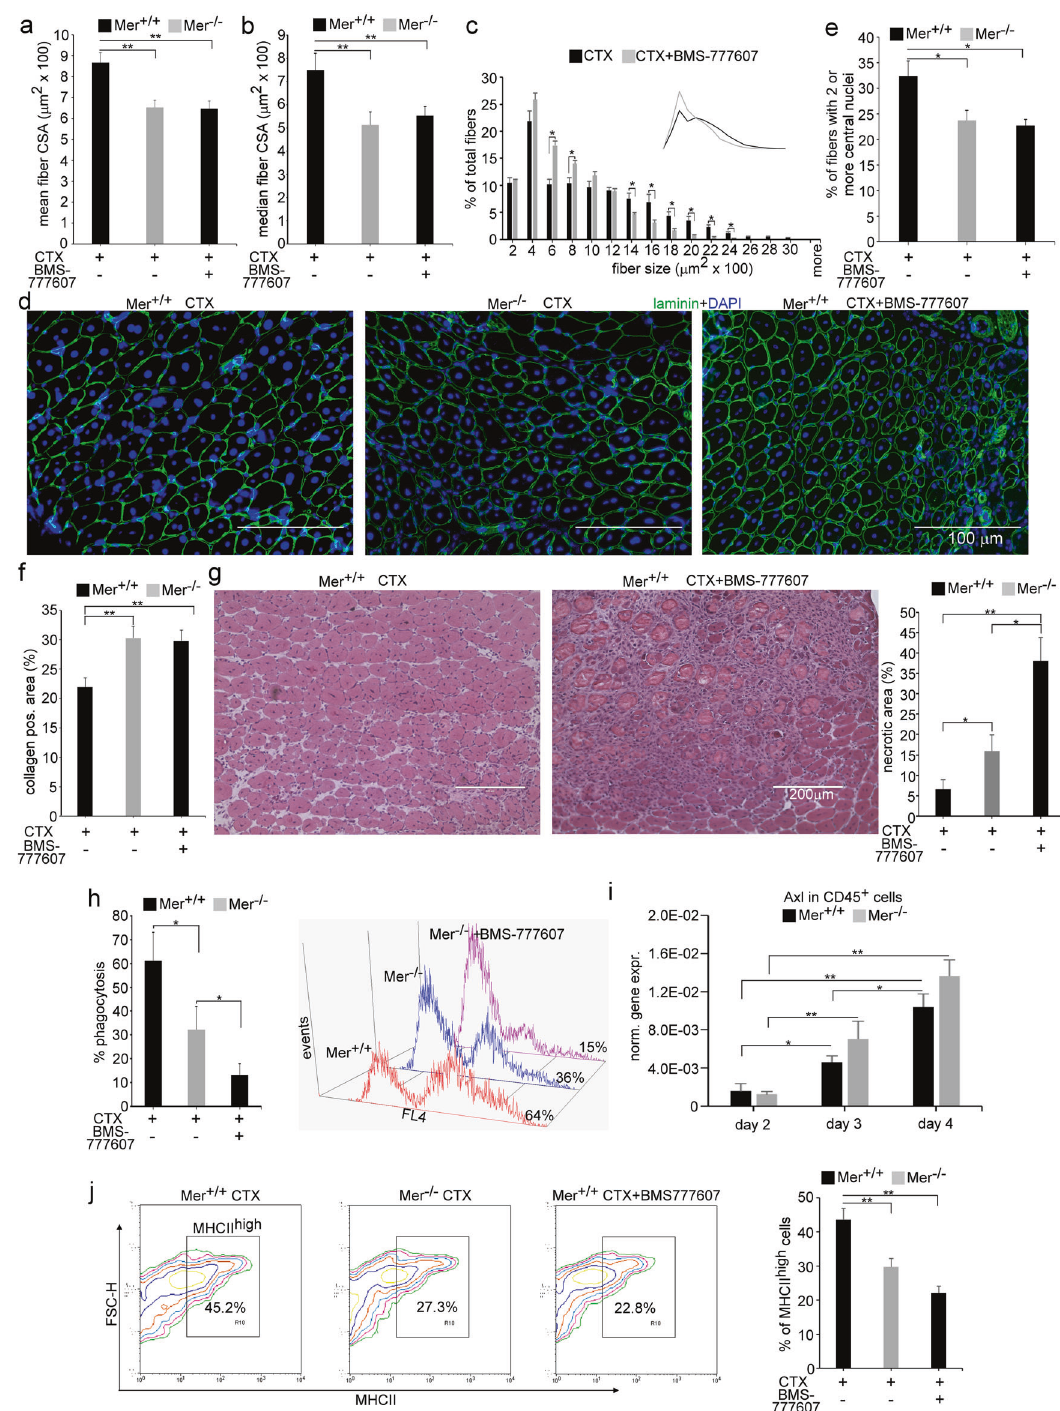
myoblasts to BMS-777607 in growth medium led to a slower cell growth rate by the third day (Fig. 6c). The reduced growth rate, however, was not the result of a reduced cell proliferation detected by the percentage of pS10 histone H3-positive cells (Fig. 6d), rather that of an increased rate of cell death (Fig. 6e). Shifting C2C12 cells to the low-serum fusion medium also resulted in an inhibition of the cell growth rate by the third day, but it was more pronounced in the inhibitor-exposed cells (Fig. 6f). The number of myoblasts did not change during the following days of Cell Death and Disease (2021)